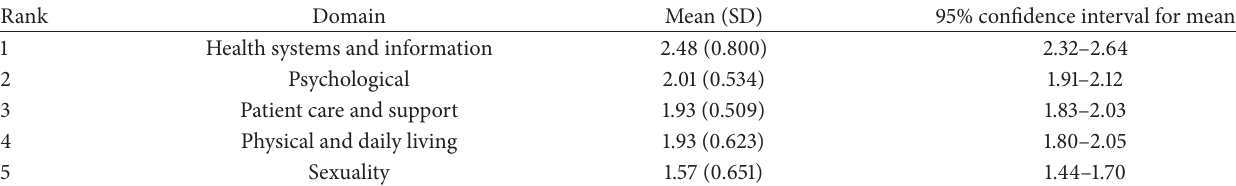
Table 2: Domain mean score ( 𝑁 = 101